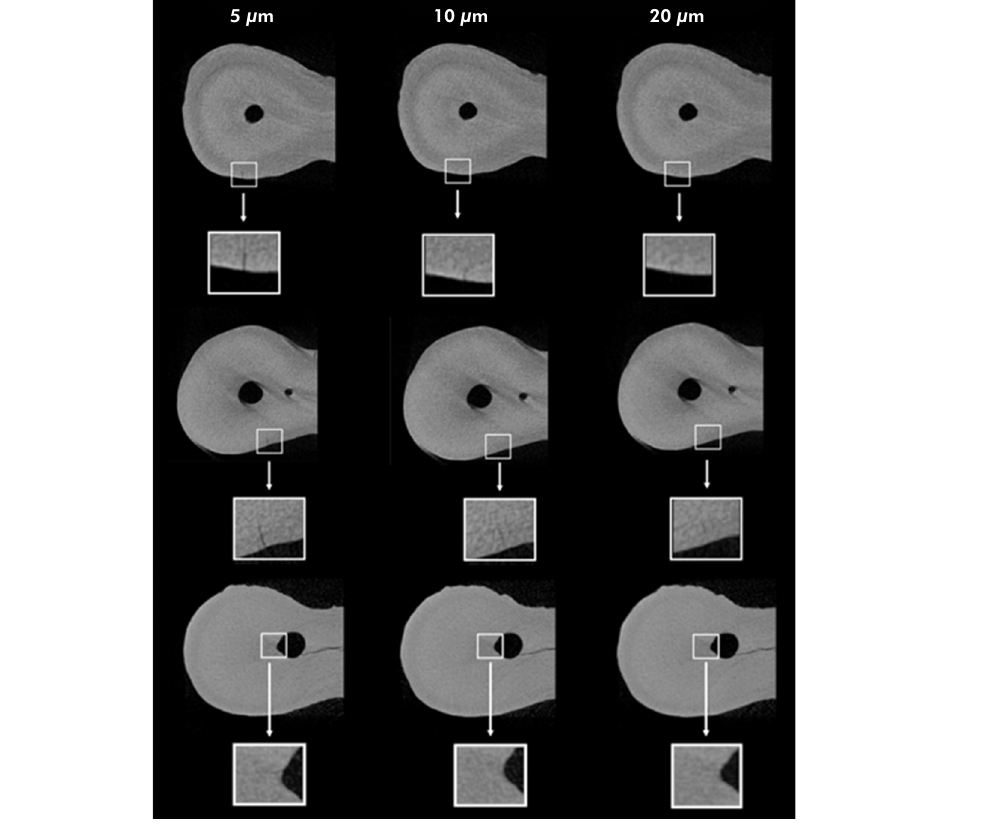
Figure 2. Representative cross-sectional micro–CT images showing a thinner continuity of microcracks based on different voxel sizes.